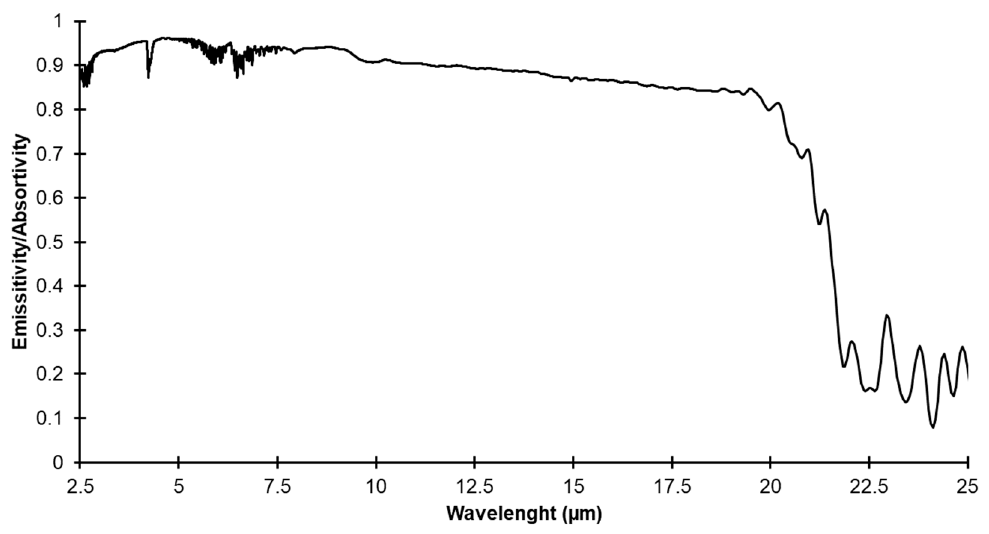
Figure 5. FT-IR spectra of the cellulose fiber sheet-based radiator.